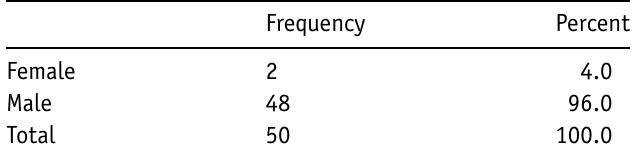
Table II. Diagram 1 – Distribution as per